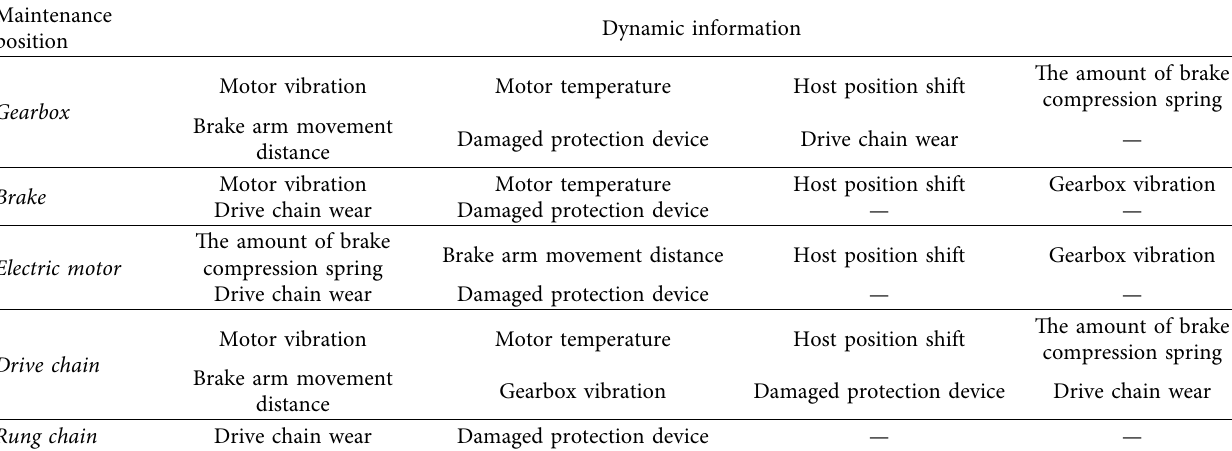
Table 2: Dynamic information obtained.